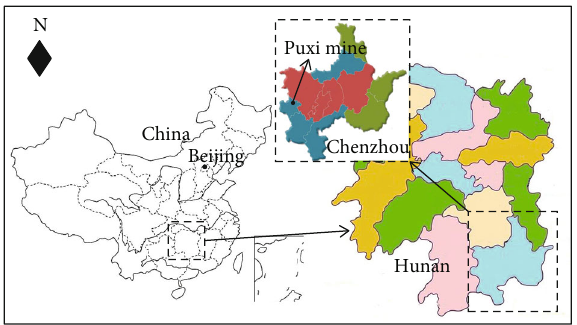
Figure 1: Location of Puxi